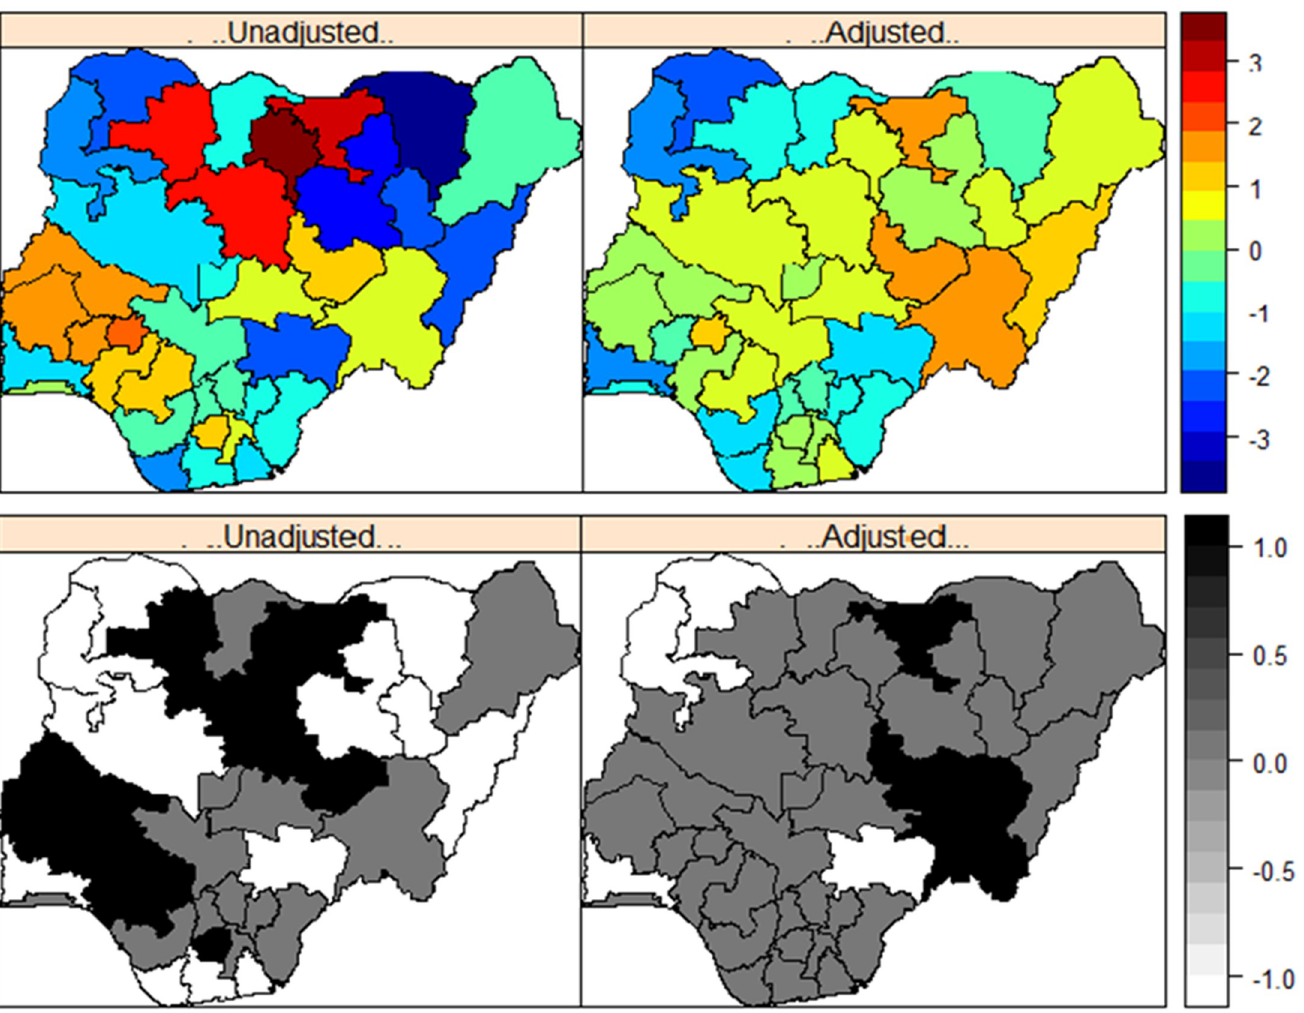
Fig 4. Posterior estimates of the effects of a girl’s likelihood of undergoing FGM/C in Nigeria based on the 2016 MICS dataset. Mean (top panel). Significance maps of the posterior estimates based on 95% credible interval (bottom panel). Dark blue to dark red represent lowest to highest FGM/C risk states. Black, white and grey represent significantly high, low, and nonsignificant FGM/C risk states, respectively. Shapefile republished from DIVA-GIS database (https://www.diva-gis.org/) under a CC BY license, with permission from Global Administrative Areas (GADM), original copyright